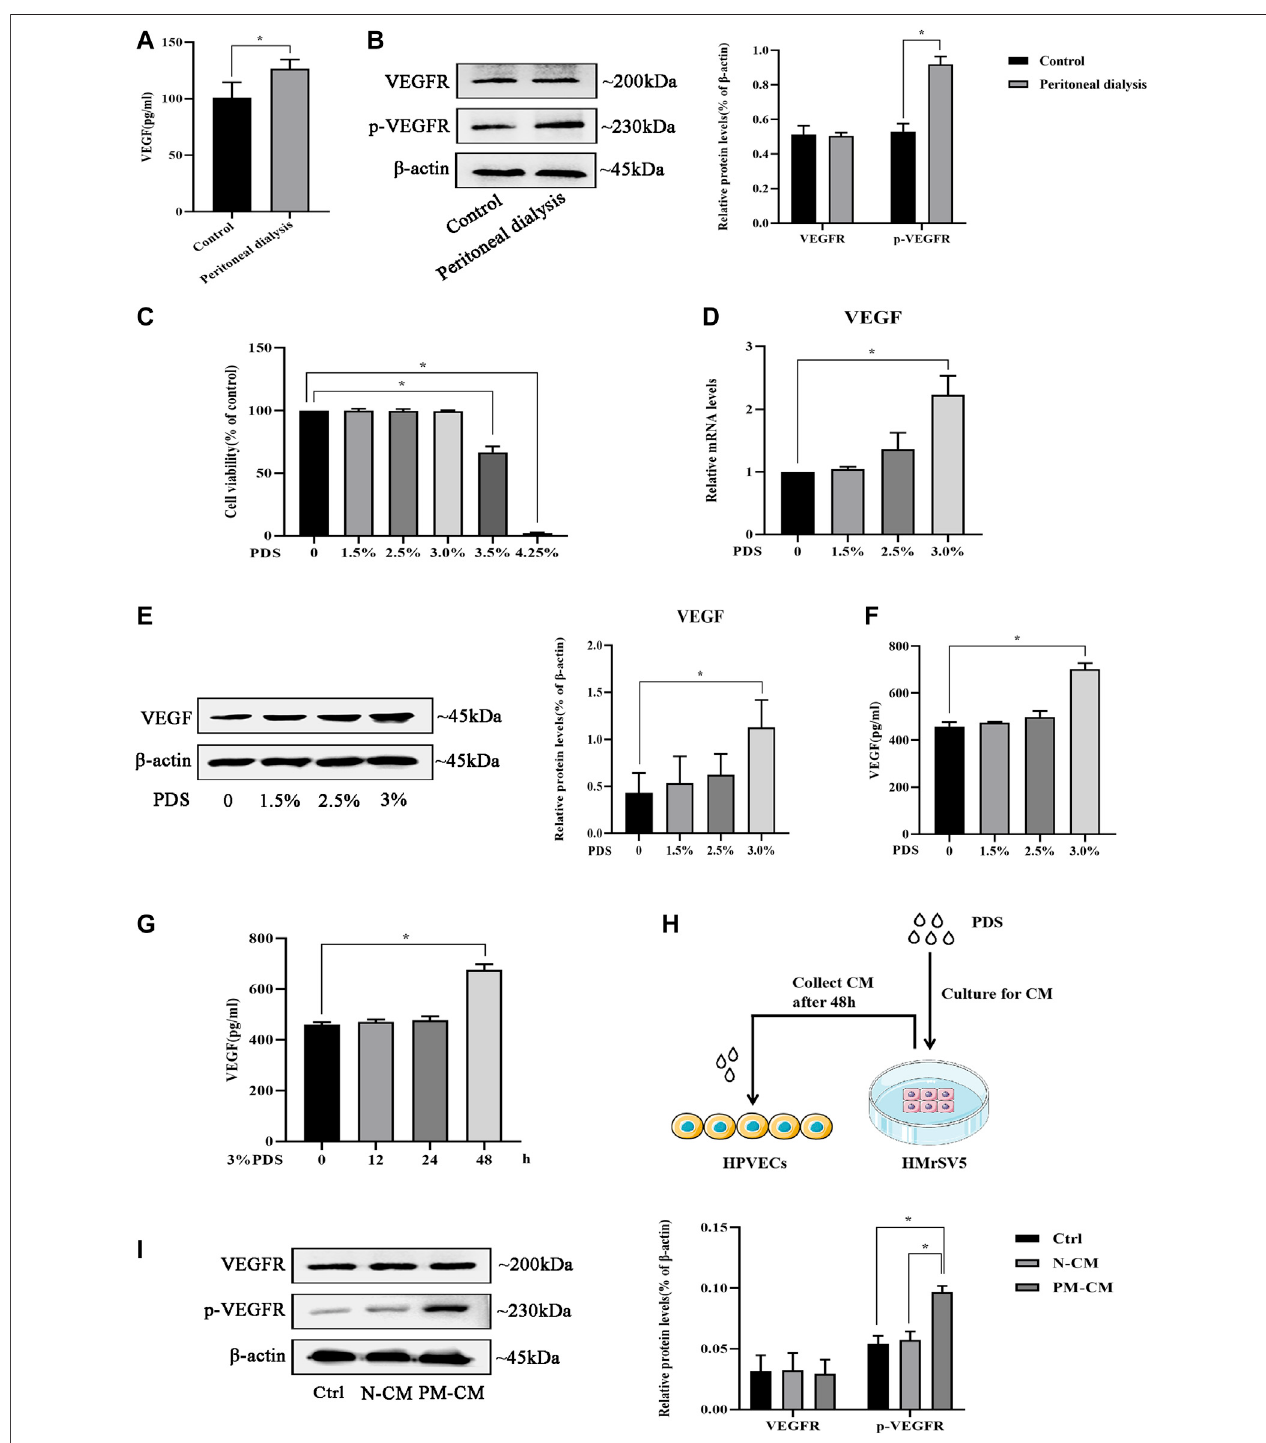
FIGURE1| VEGF/VEGFR signalingisactivated byperitonealdialysis(PD). (A,B) PDmice weretreatedwith4.25%dextroseperitonealdialysissolution(PDS)daily for 30 days. (A) VEGF concentrations were determined in the peritoneal lavage of the control group and the PD group by ELISA. (B) Western blotting assay was used to detect VEGFR and p-VEGFR protein expressions of peritoneal tissues in the control group and the PD group. (C) HMrSV5 cells were treated with PDS at various concentrations(0,1.5,2.5,3,3.5,and4.25%).However,3.5and4.25%dextrosePDScausedstrengthenedcellapoptosis. (D,E) HMrSV5cellsweretreatedwith PDS at various concentrations (0, 1.5, 2.5, and 3%) and subjected to real-time PCR for VEGF mRNA expression (D) and western blotting for VEGF protein expression (E) . (F, G) ELISA was used to detect VEGF concentrations in HMrSV5 supernatants. (F) HMrSV5 cells were treated with serial concentrations of PDS (0, 1.5, 2.5,